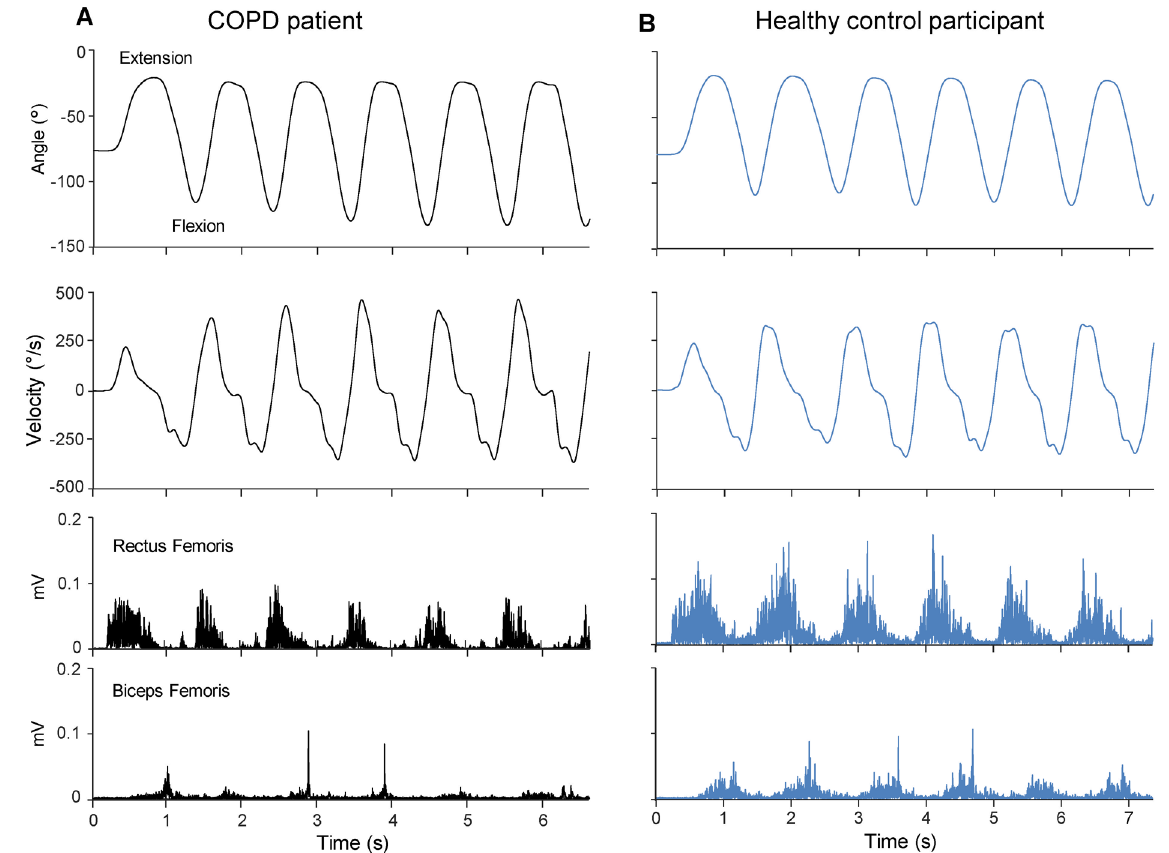
Figure 4. Representative examples of kinematic and electromyographic traces during voluntary flexion– extension movements. Angular displacement, velocity, rectified EMG activity of Rectus Femoris and Biceps Femoris muscles, recorded in one patient with COPD ( A ) and one healthy control participant ( B